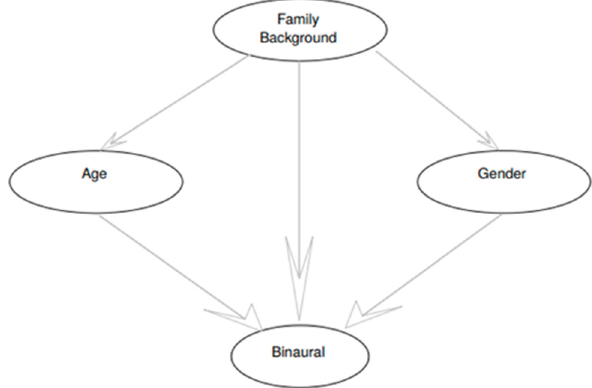
Figure 3. Subgraph of the Bayesian network. Source: Compiled by authors.